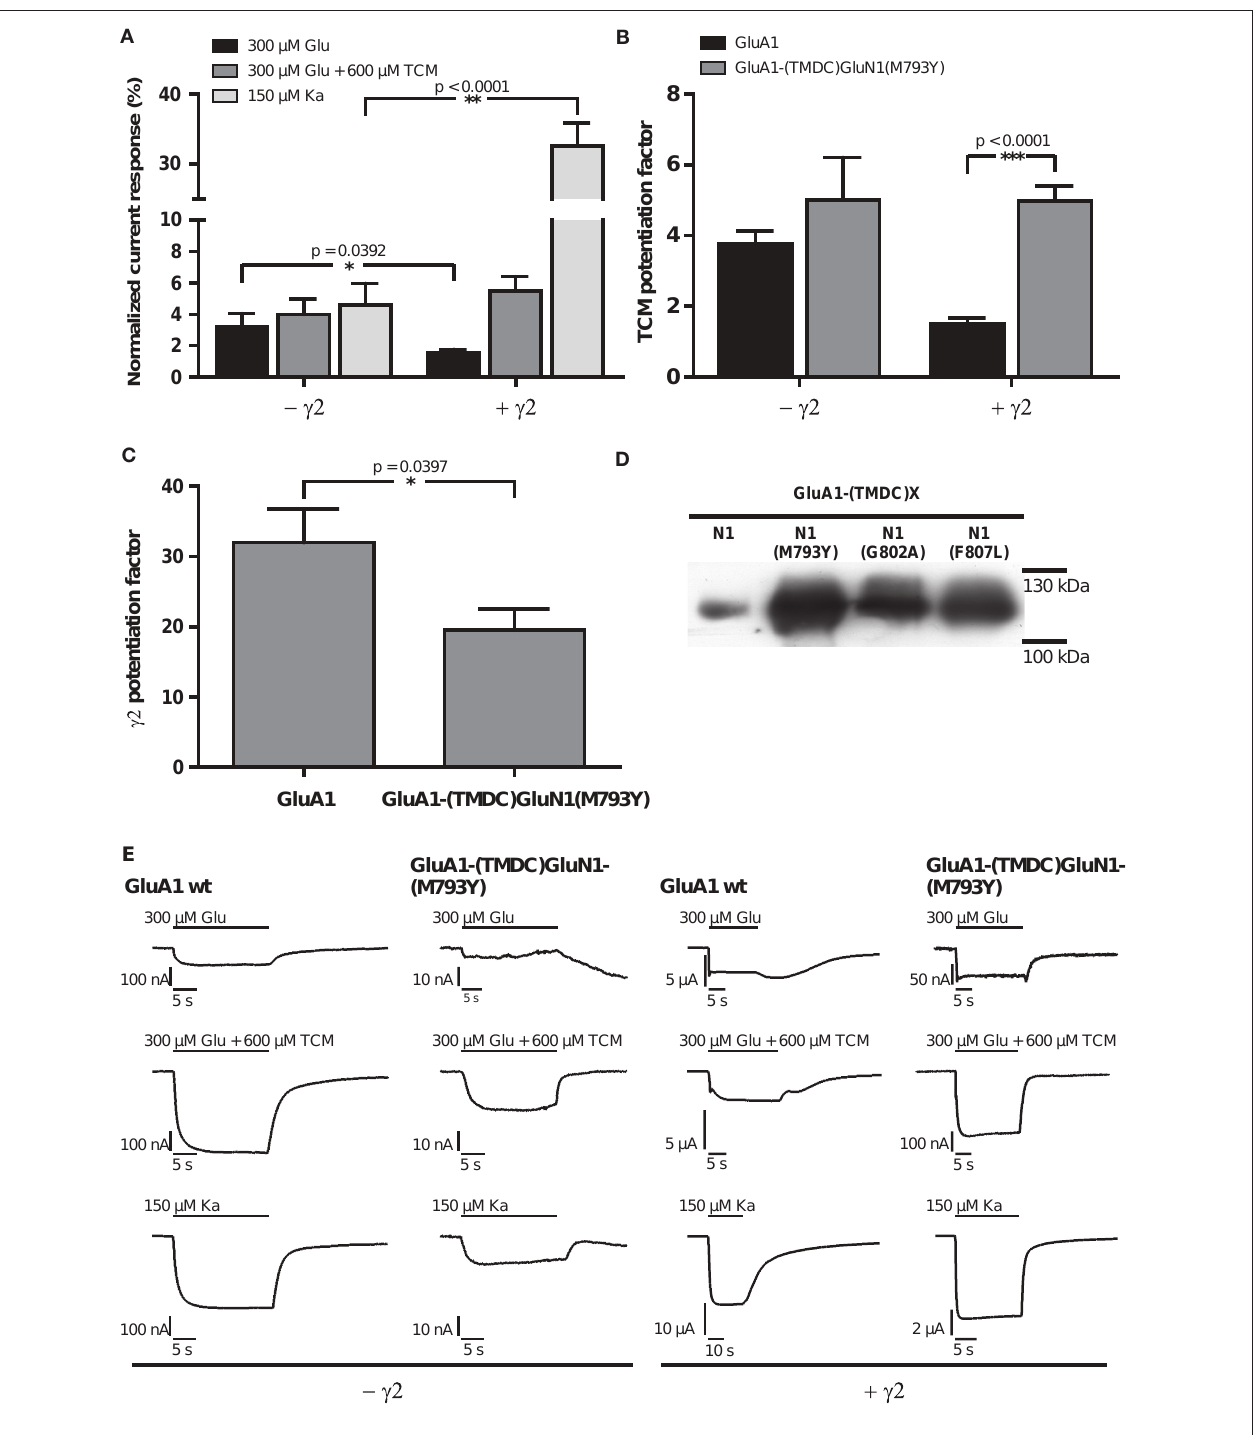
GluN1. (e) Exemplary current traces of GluA1 wild type and GluA1-(TMDC) GluN1(M793Y). Glutamate-induced currents are shown in the top row, glutamate-induced currents in presence of TCM are shown in the top row, and kainate-evoked currents in the bottom row; currents recorded in the absence of the TARP γ 2 are shown in the left half of the figure, currents observed in its presence in the right half. Please note different scaling and